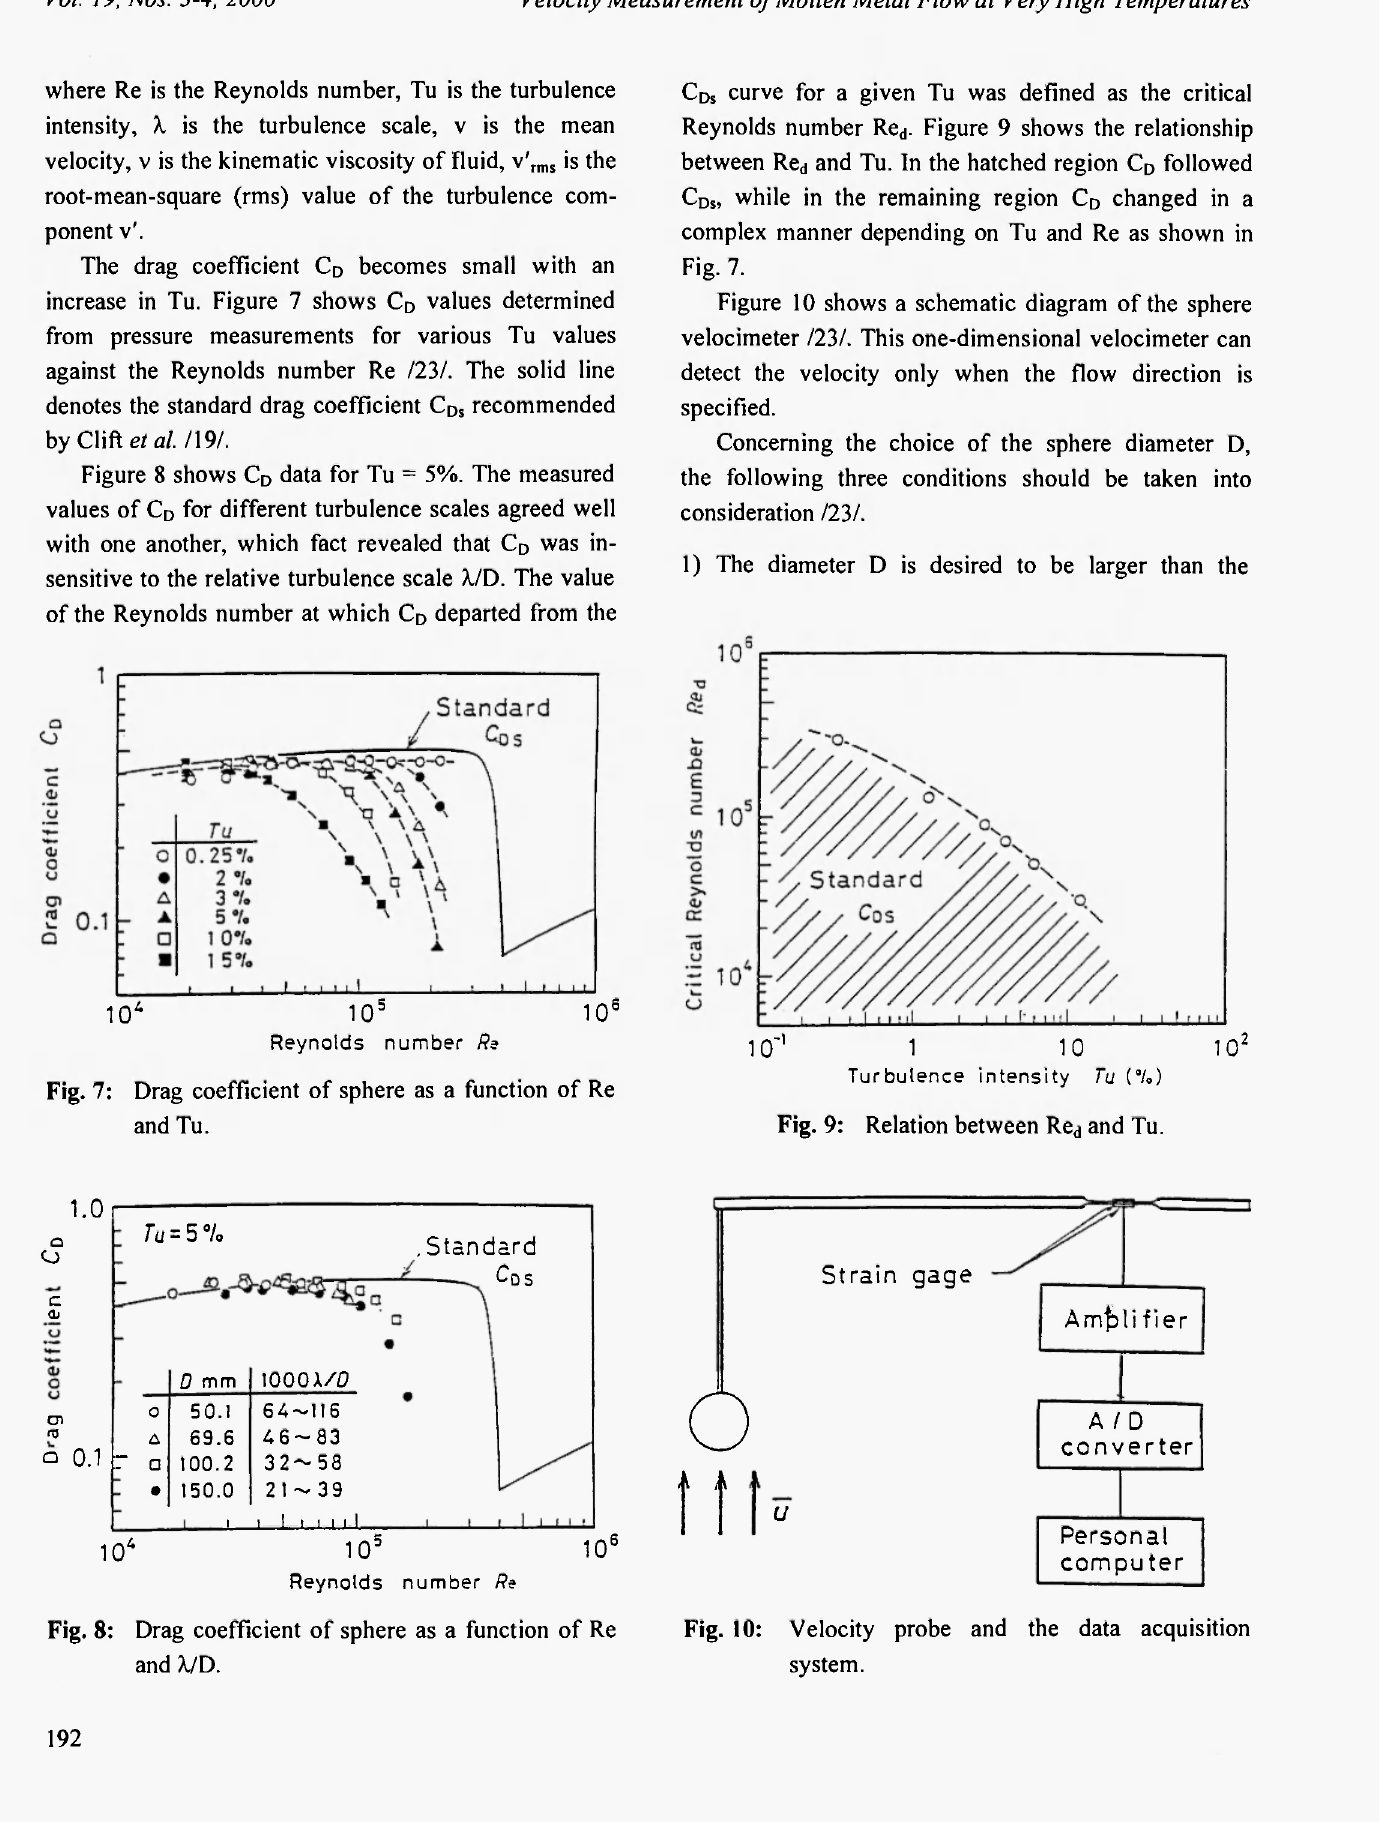
Fig. 10: Velocity probe and the data acquisition